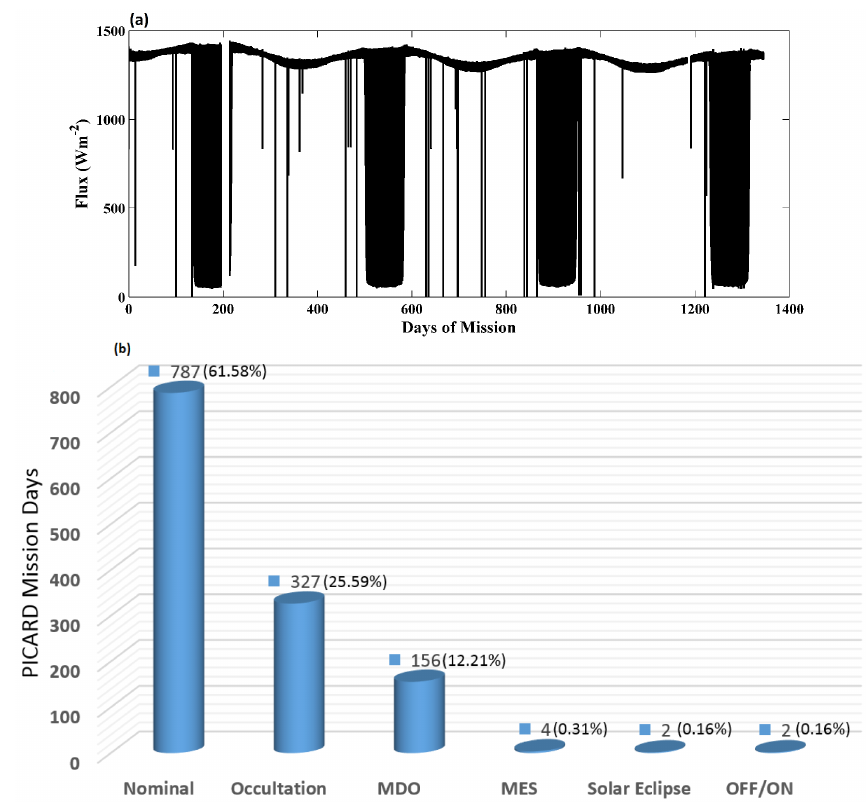
Figure 4. Observations during the entire PICARD mission. (a) Level 2 thermal flux. (b) Data partition according to its physical origin; unit is the day. Nominal: the measurements without any special operation. Occultation: observation during the satellite occultation by the Earth; it is related to the orbit of PICARD. MDO (MOde Distortion): the satellite is rotating along its Sun-pointing axis. MES (ModE Stellar): the Sun-pointing axis is turning away to a star. OFF/ON: the SOVAP experiment is switched off and on to test the electrical ground. Table 2. MES calibration